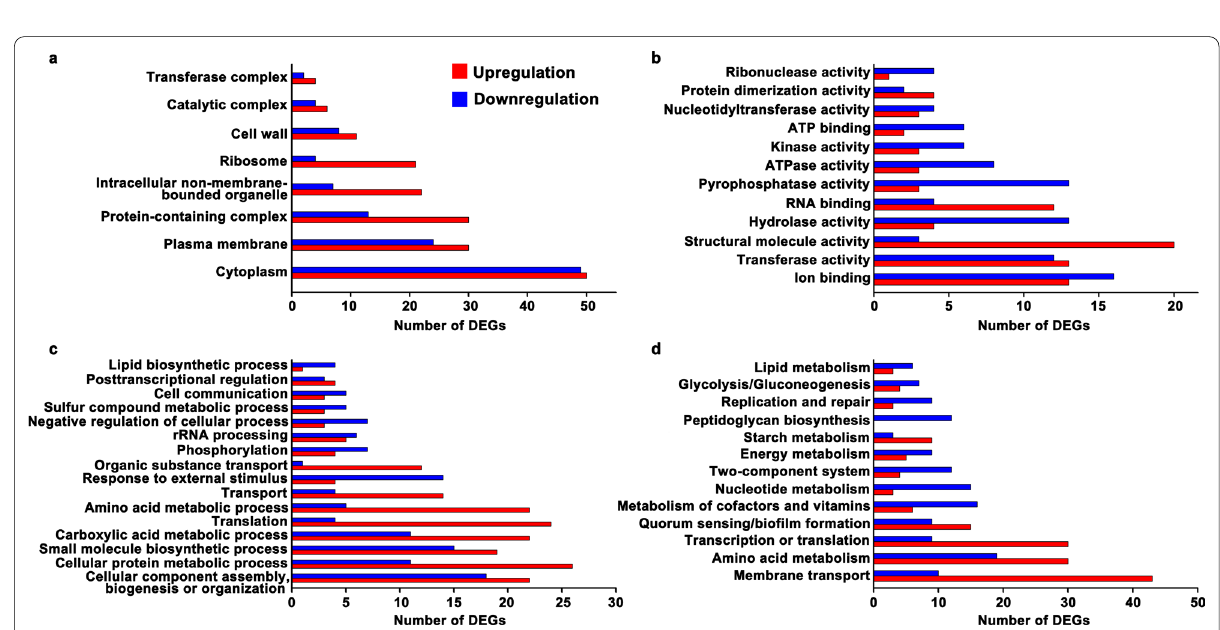
Fig. 5 GO and KEGG enrichment cluster analyses of the differentially expressed genes. The DEGs related to cellular component ( a ), molecular function ( b ), and biological process ( c ). d KEGG pathway cluster of the differential